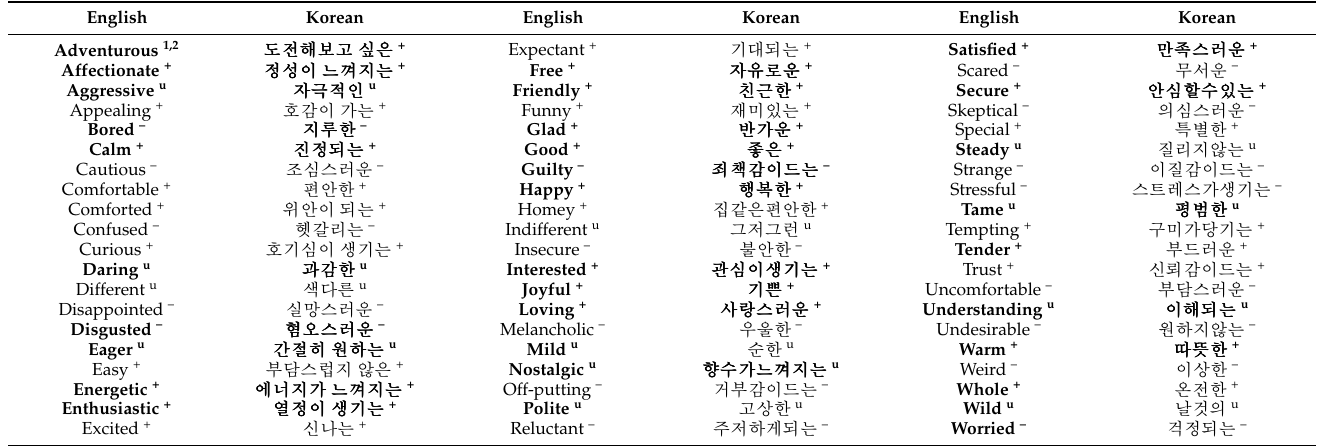
Table 2. A list of the 60 emotion terms elicited by the nine stimuli in the focus group interviews (FGIs). English